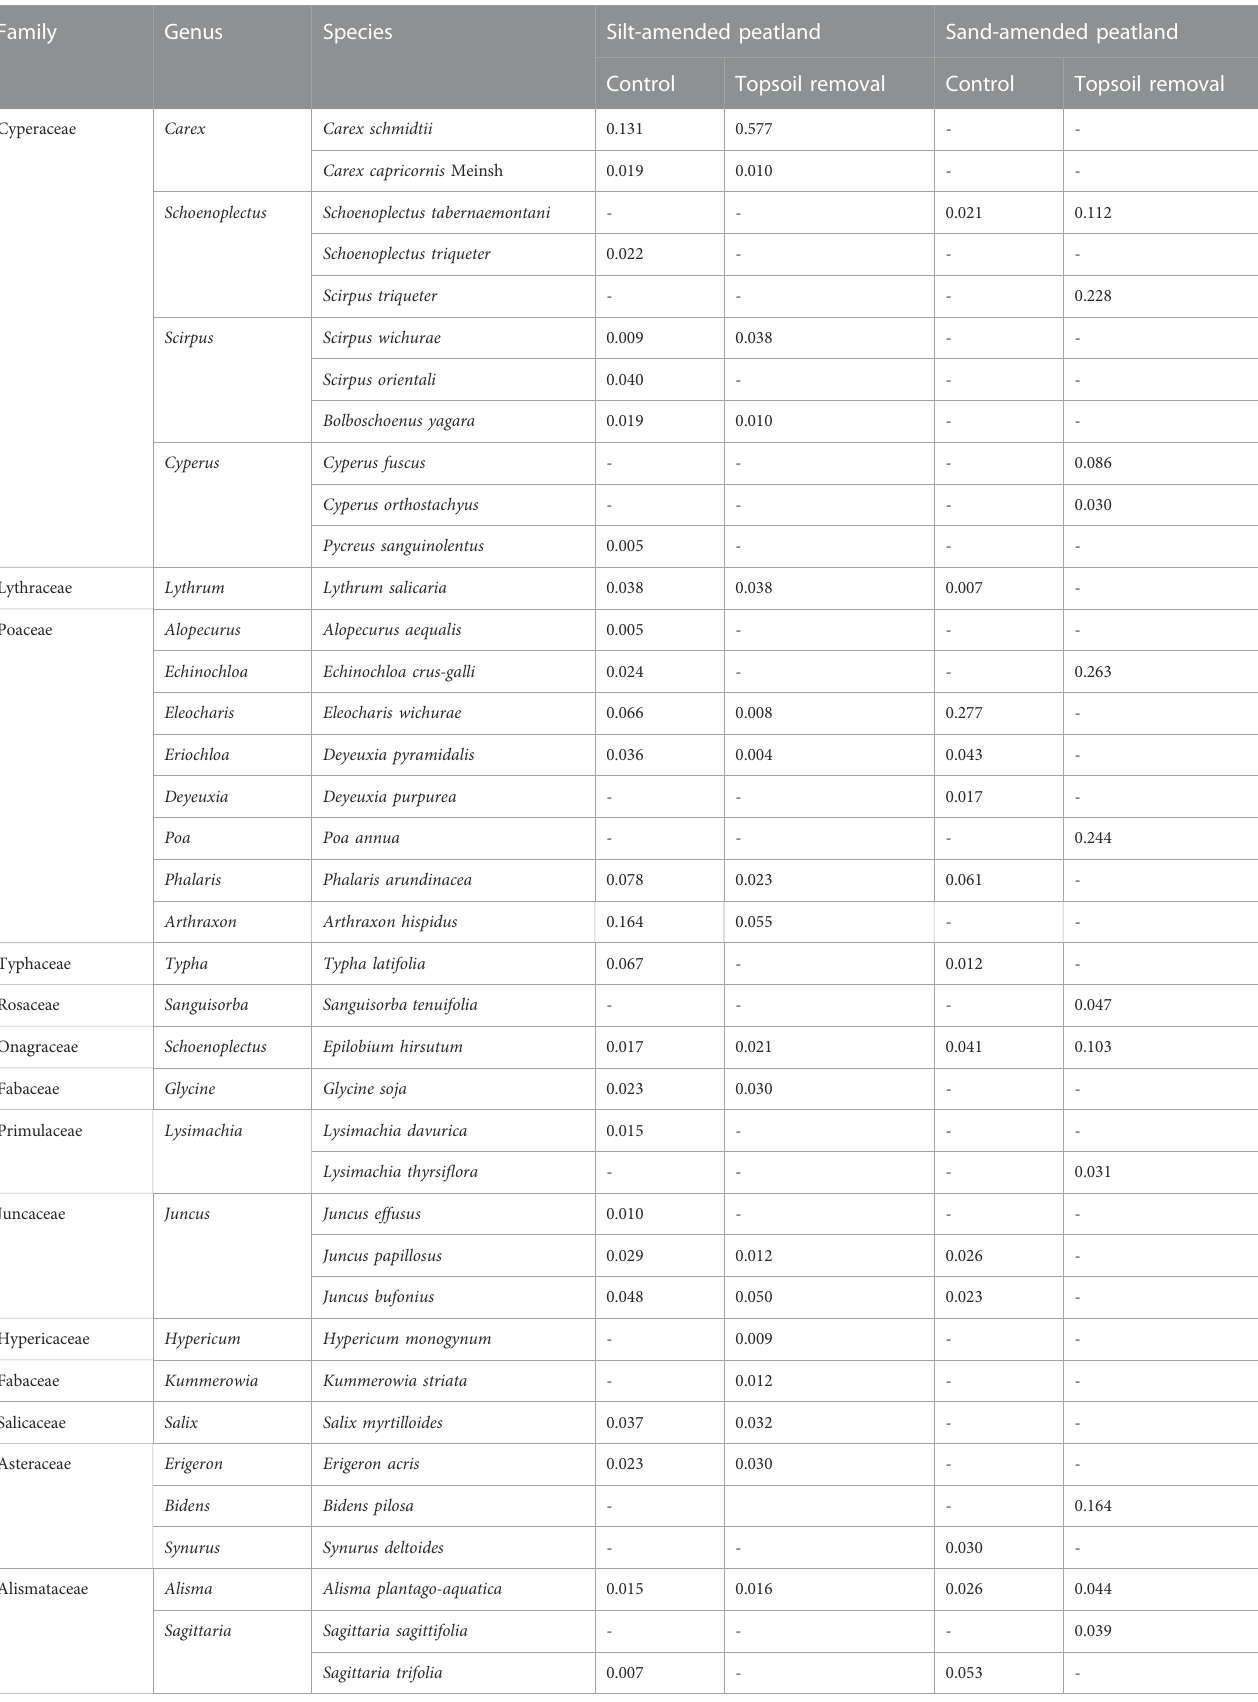
TABLE 2 Species that emerged in the vegetation plots and their importance values in the silt-amended and sand-amended peatlands.